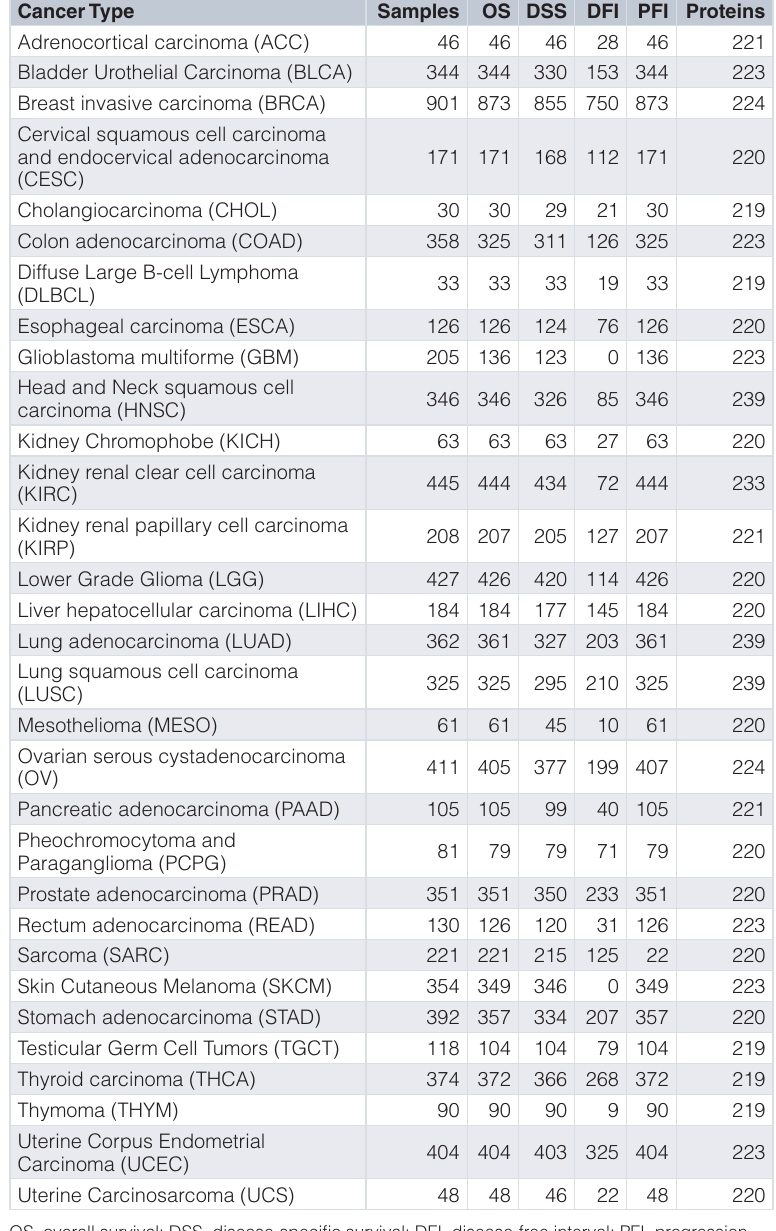
Table 1. Survival information and protein summary available in